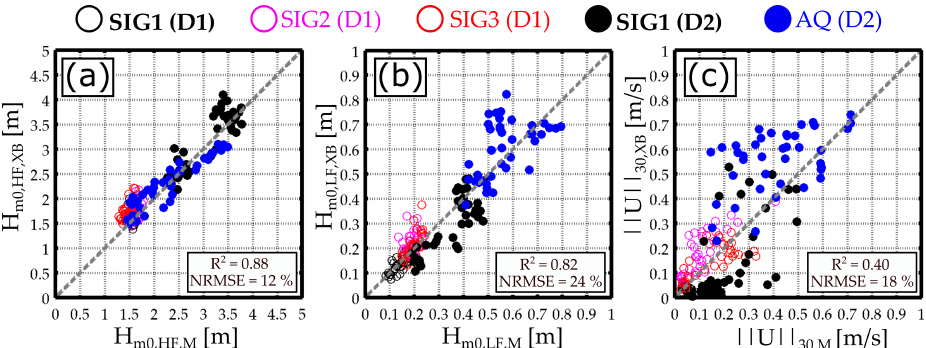
Figure 4. Measurements (subscript M) versus model (subscript XB) for events D1 and D2 and for each instrument. ( a ) Significant short wave height ( H m0,HF,M and H m0,HF,XB ); ( b ) Significant infragravity wave height ( H m0,LF,M and H m0,LF,XB ); ( c ) 30 min-averaged velocity magnitude ( || U || 30,M and || U || 30,XB ). The corresponding coefficient of correlation R 2 and normalized root-mean-squared error (NRMSE) are indicated in each